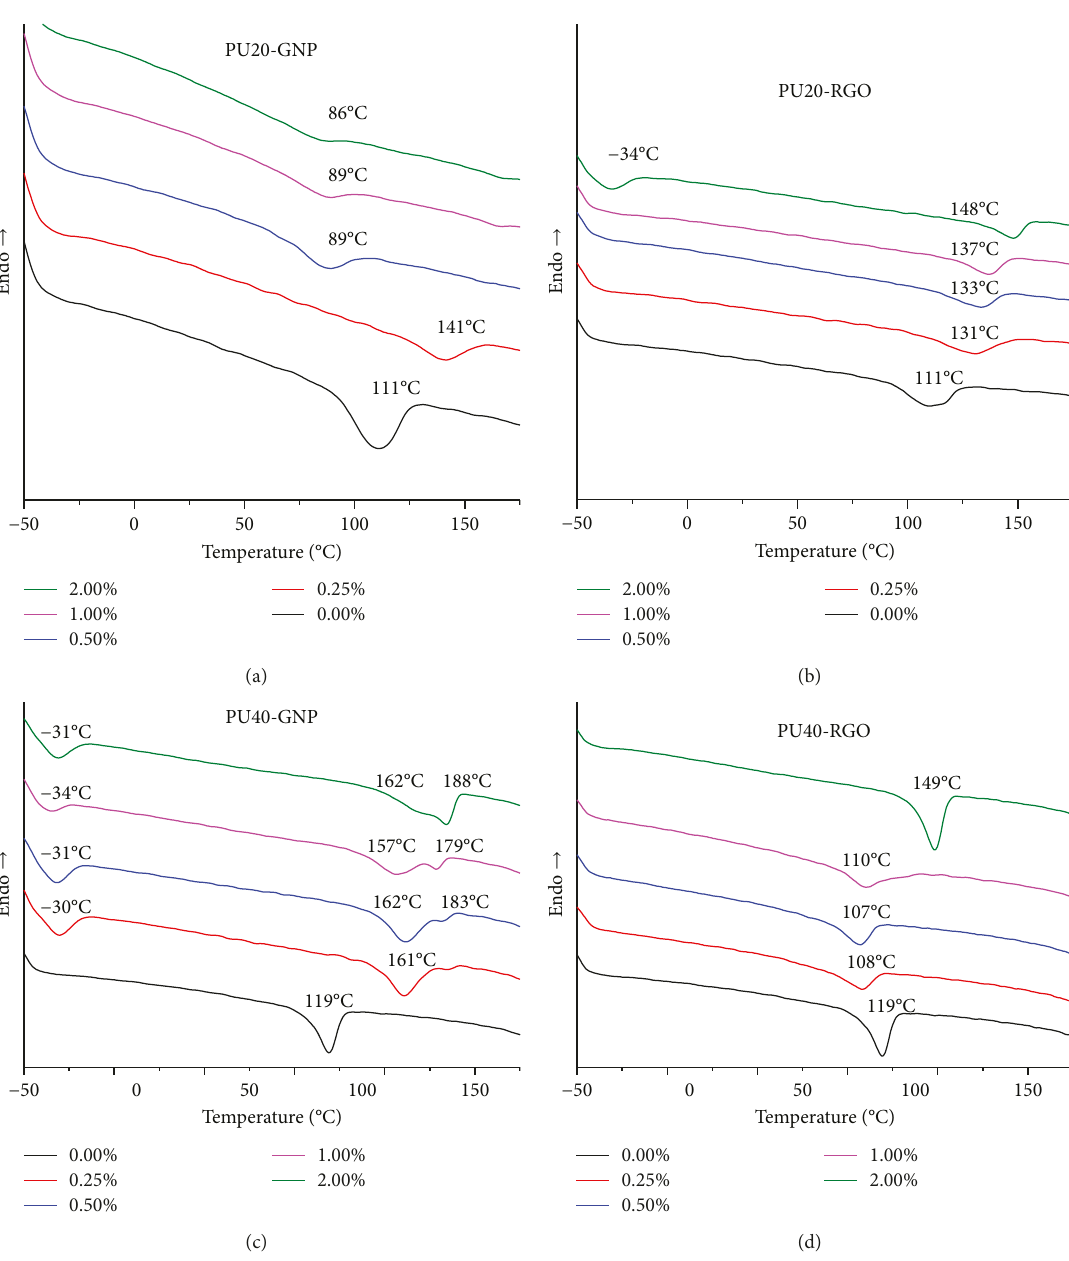
Figure 11: DSC thermograms for PU nanocomposites (cooling